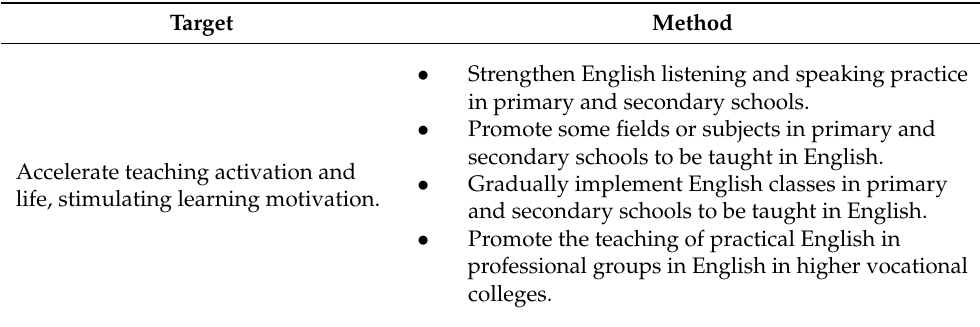
Table 1. Comparison of learning process and traditional assessment